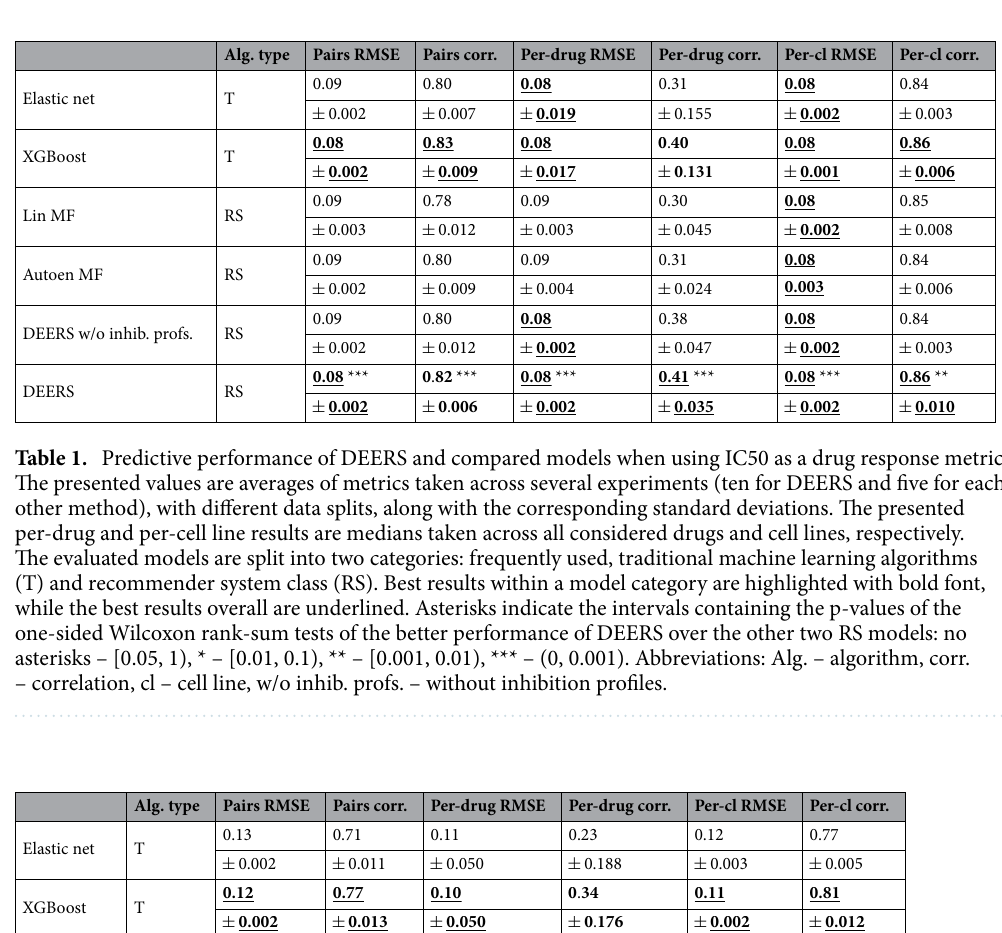
to PHA-793887, hidden dimension 3 carries the most information about cell lines response to XMD14-99 and thus we can conclude that the same biological processes may be associated with the response to these two drugs (Fig. 3b, bottom row panel). In the case of Dabrafenib, both drug and cell line feature sensitivities are consistent with its design and clini- cal usage. Dabrafenib is a selective inhibitor of mutant BRAF kinase, approved by the FDA for the treatment of metastatic melanoma with mutant BRAF(V600) 48,49 . Accordingly, the two most important cell line features are BRAF mutation and skin tissue indicator (Fig. 3c, second row panel). The inhibition of BRAF also emerges among the most informative drug features, though being preceded by the inhibition of RAF1, MLK and AMPK (Fig. 3c, top row panel). The hidden dimensions 3 and 4 capture significant information about cell lines response (Fig. 3c, third row panel), with the hidden dimension 4 being the sole good indicator of the Dabrafenib efficacy (Fig. 3c, fourth panel). The hidden dimension 4 has nine positively enriched biological process terms associated with it (Figs. 2; 3c, bottom row panel). Thus, we conclude that a better response to Dabrafenib corresponds to the over-expression of genes involved in: neutrophil mediated immunity, positive regulation of I-kappaB kinase/NF- kappaB signaling, regulation of cell migration, post-translational protein modification, cellular protein metabolic process, cellular protein modification process, extracellular matrix organization, regulated exocytosis, and cell morphogenesis involved in differentiation. Associating biological processes to all of the analyzed drugs. In the final step of the interpretability analysis, we associate biological processes to all of the analyzed drugs. This analysis is based on the idea behind the bottom panels of Fig. 3. Just like for PHA-793887, XMD14-99 and Dabrafenib, we can calculate the correla-